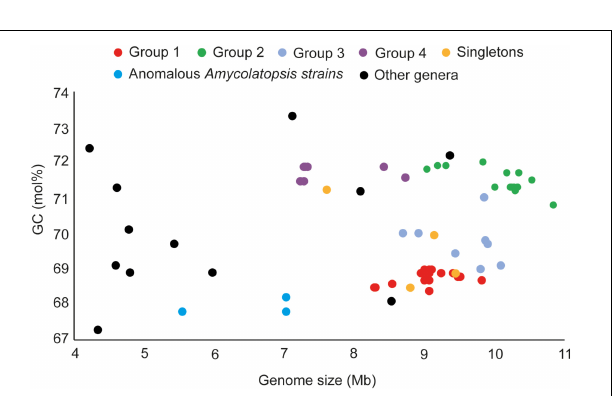
FIGURE 3 | Distribution of genome sizes and GC contents among the different phylogenetic